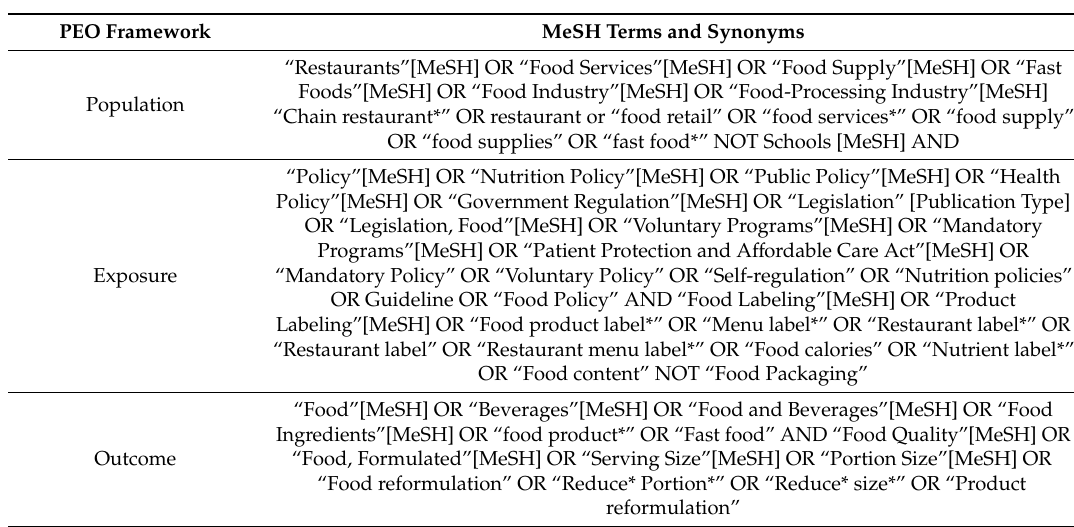
Table 1. Systematic search strategy for the scoping